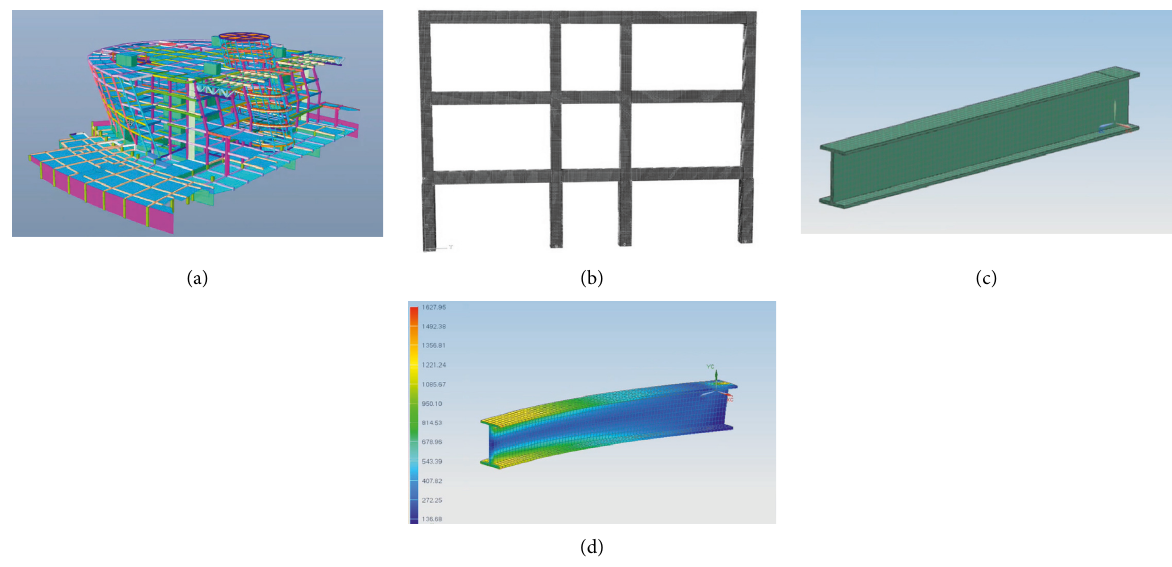
Figure 1: Finite element analysis model. (a) multistory and high-rise steel structure model; (b) grid division of reinforced concrete frame strengthened with local universal beam; (c) local universal beam model; (d) local universal beam